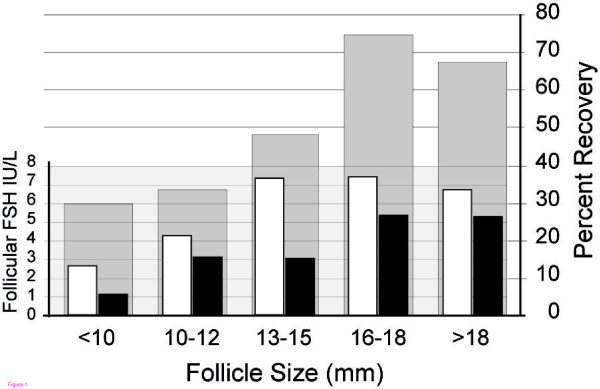
Follicular FSH level and oocyte recovery. Rate of oocyte recovery and concentration FSH versus Rate of recovery (gray bars) and FSH concentration in cases of oocyte capture (white bars), and no oocyte capture (black bars). FSH p = 0.007 Oocyte recovery across follicles sizes p <0.001